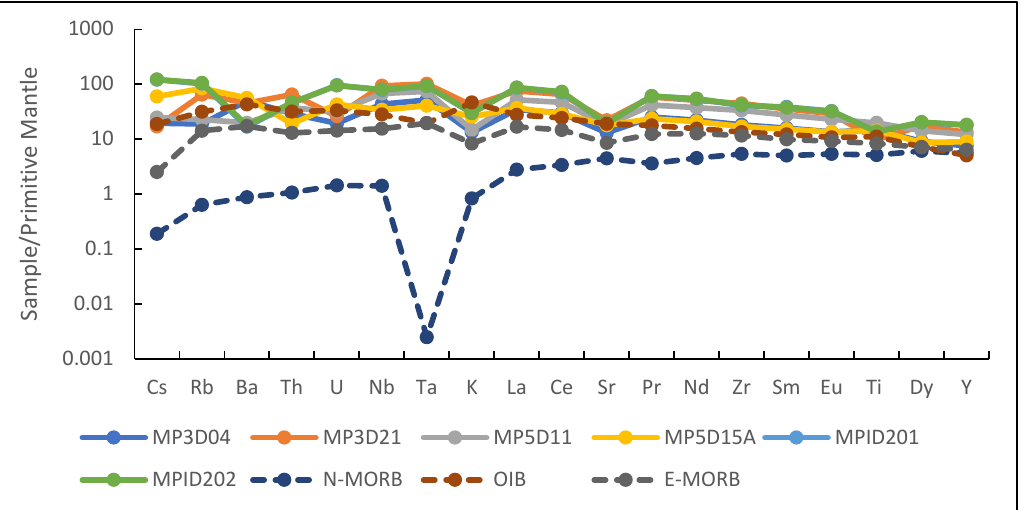
Figure 5. Primitive ‐ mantle ‐ normalized diagram of trace elements (ppm) in seamount basalt samples from the Western Pacific. (Primitive mantle datas are after Taylor, S.R. et al., 1985 [30]).